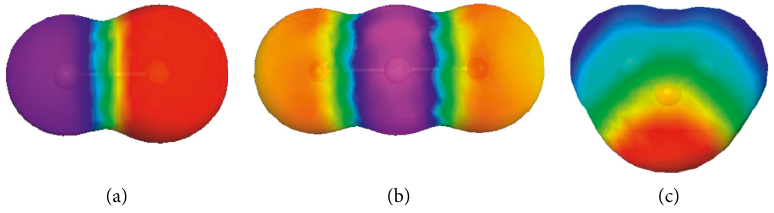
Figure 1: The sigma surface of NaCl, CaCl2, and H2O in COSMOtherm.